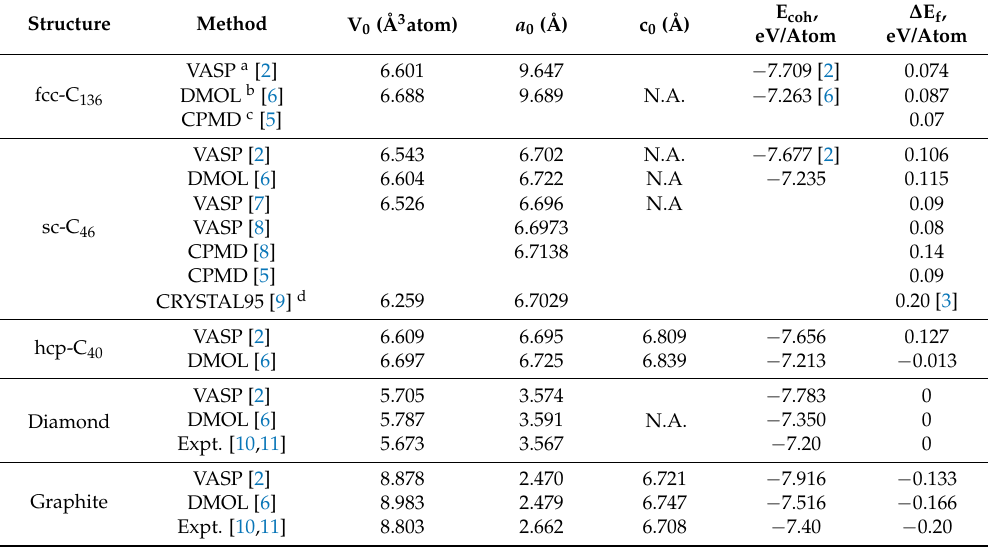
Table 1. Calculated equilibrium volume (V 0 in Å 3 /atom) and lattice parameters (a 0 , c 0 in Å), cohesive energy (E coh ), and energy of formation ( ∆ E f ) for fcc-C 136 , sc-C 46 , hcp-C 40 , diamond, and graphite at zero pressure, compared to available experimental data for diamond graphite and calculated data for C 46 and C 136 . Modified from Wang et al.